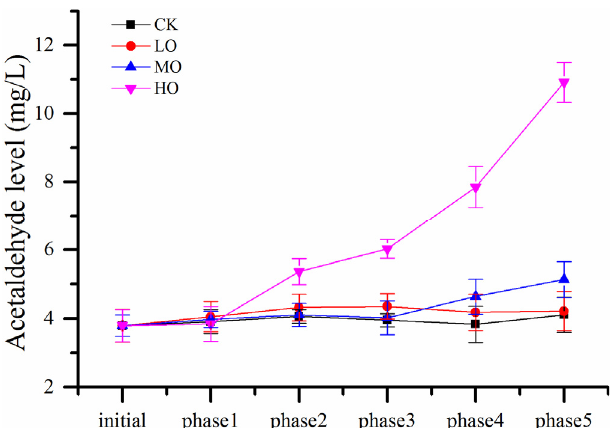
Figure 2. The evolution of acetaldehyde during oxygen treatment. Note: phase corresponds to Section 3.1. Abbreviations: initial, initial wine before oxidation treatment; CK, anaerobic wine (0 mg O 2 /L per time); LO, low-level oxygenation wine (0.5–0.9 mg O 2 /L per time); MO, medium-level oxygenation wine (1–1.9 mg O 2 /L per time); HO, high-level oxygenation wine (3–3.9 mg O 2 /L per